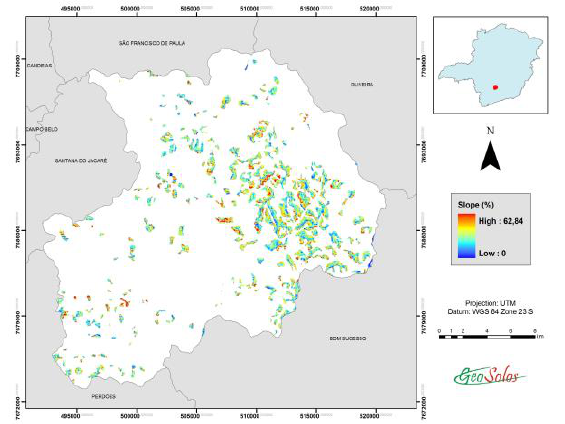
Figure 5. Slope (%) of coffee fields of Santo Antonio do Amparo, Minas Gerais, Brazil.